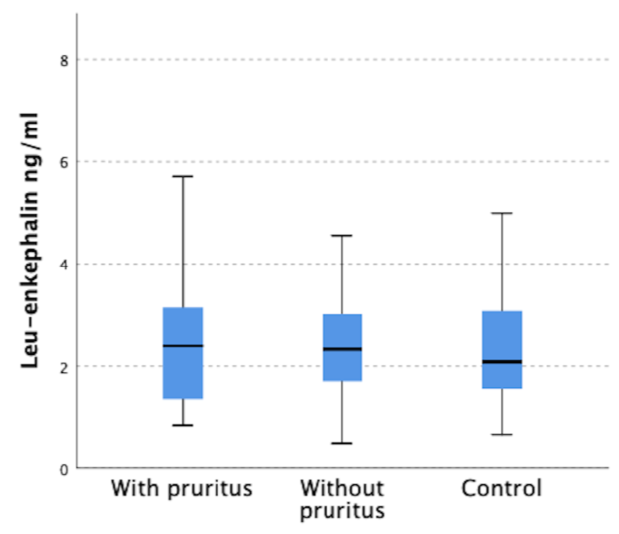
Figure 4. Serum level of Met-enkephalin in patients with pruritus, without pruritus, and control group. * p = 0.009.